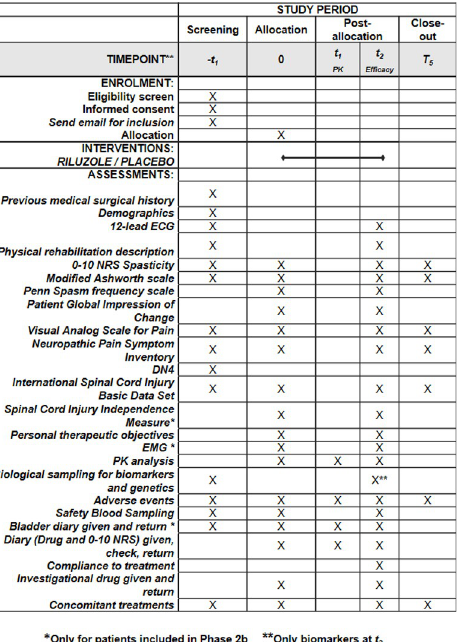
Fig 1. Standard protocol items recommended for interventional trials (SPIRIT). Schedule of enrolment, intervention and assessments. The study schedule will be the same in step 1 and in step 2 and it includes the following visits and clinical examinations. Patients with chronic SCI will undergo a screening period (v1) with a maximum duration of 2 weeks and then they will be randomized to one of the two groups (v2): riluzole twice daily or placebo twice daily for a 2 weeks period. Three follow up visits are planned: at day3 after the beginning of treatment for PK analysis (v3), and at the end of the 2 weeks treatment period (v4) and one week after withdrawal of study medication